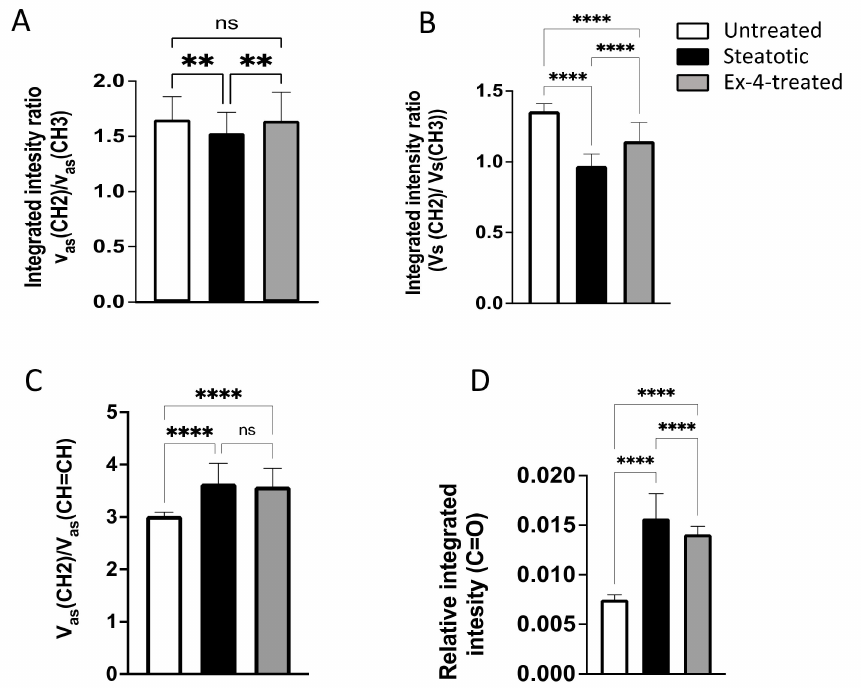
Figure 4. Comparison of several representative spectral parameters between untreated, steatotic, and Ex-4-treated HepG2 cells. ( A ) V as (CH 2 ):V as (CH 3 ) ratio. ( B ) V s (CH 2 ):V s (CH 3 ) ratio. The ( C ) V as (CH 2 ):V as (CH=CH) ratio. ( D ) The phospholipid band (C=O) at 1740 cm − 1 . All the val- ues are expressed as the mean ± SE. The FTIR spectra analyzed were 70, 80, and 80 for the untreated, steatotic, and Ex-4-treated HepG2 cells, respectively. Each treatment condition was repeated three times. The comparison between the different treatments was performed using ANOVA, followed by Turkey’s post hoc test. ** and **** indicate p < 0.01 and p < 0.0001, respectively. ns: